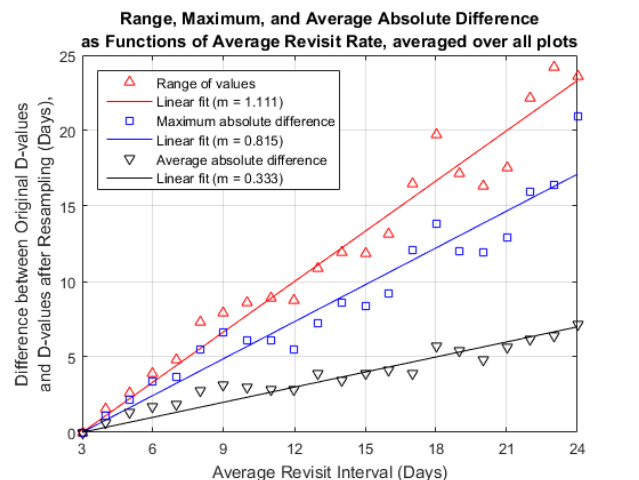
Figure 10. Range of D -values after temporal resampling, maximum absolute deviation of post-resampling D -values from original D -value, and average absolute deviation of post-resampling D -values from original D -value, shown as functions of average revisit interval. These statistics were collected separately for each individual D -value and each individual plot and were then averaged for analysis; the data points presented above represent the average of statistics across all six D -values and all 32 plots. Table 5. Statistics used for assessing the impact of average temporal revisit rate on phenological transition timing estimation. The slope of linear fit refers to the slope of the named statistic vs. the average temporal revisit rate. Metric